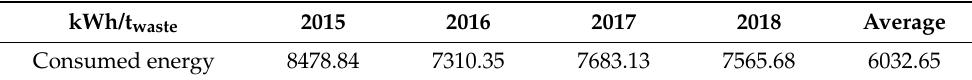
Table 11. Difference between Equations (1) and (2) (kWh/t waste ).